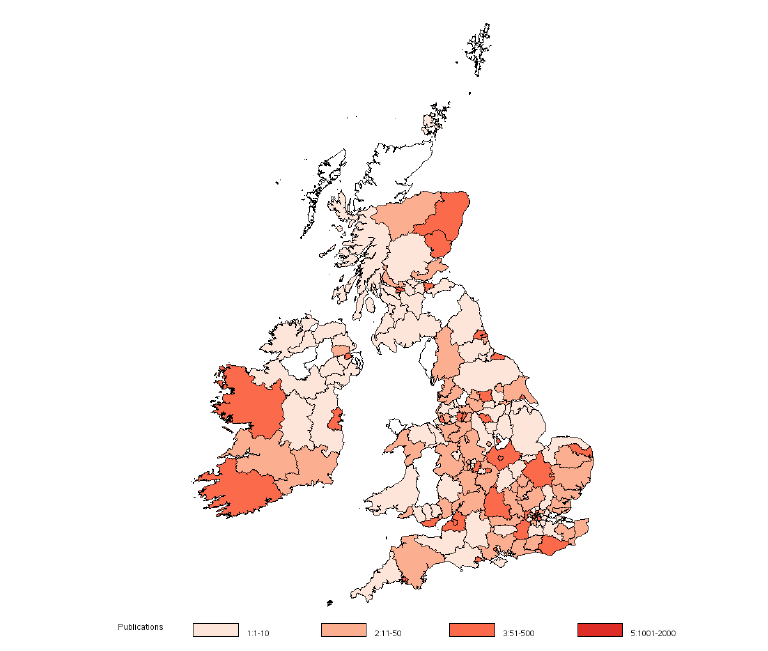
Figure A.1: Publication Output for Cardiovascluar Medical Devices at Regional levels of NUTS-3 in Europe: UK &